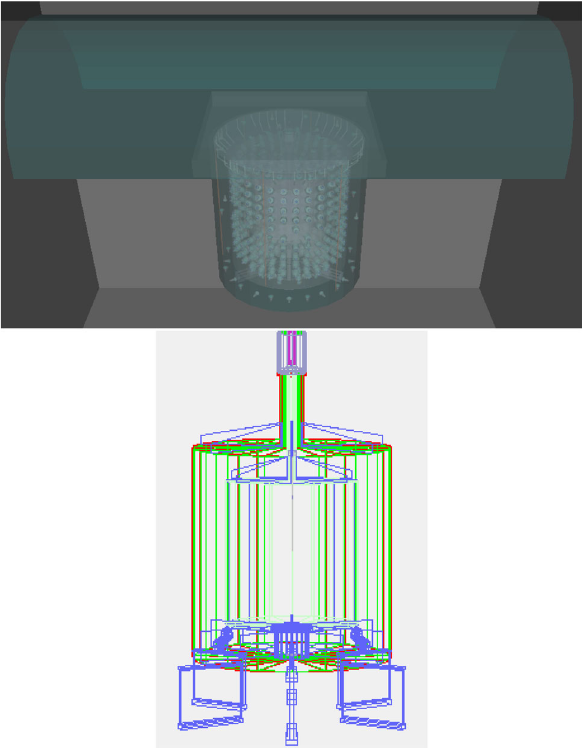
Fig. 23 VisualizationoftheDoubleChoozfardetectorgeometryusing Geant4 as it was used for the neutrino event generator. In the figure on the top each detector volume, the PMTs and also the cavern where the laboratory was built can be seen. The figure on the bottom shows the acrylic vessels including